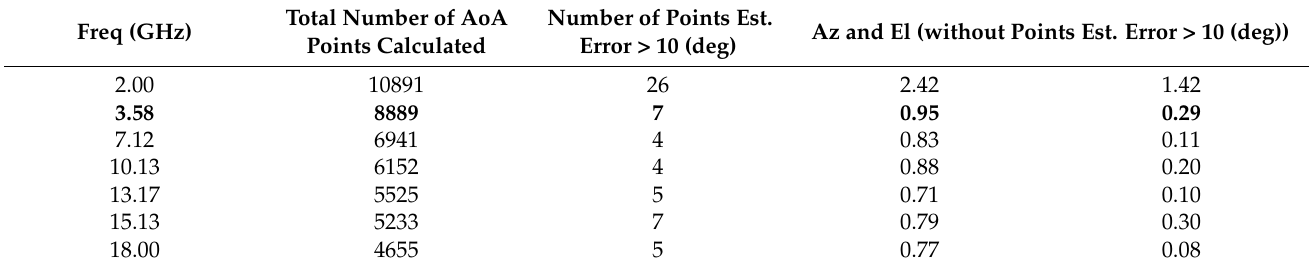
Table 6. RF HF-M&S results of AoA estimation RMSE (Deg) at other